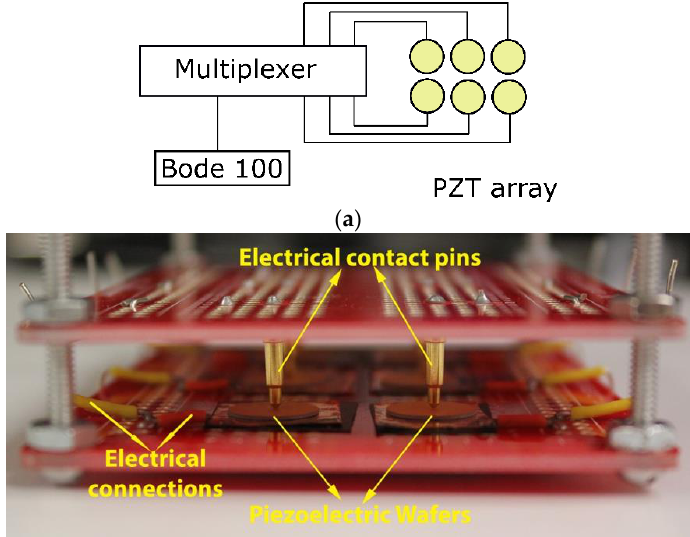
Figure 4. ( a ) Schematic of the experimental setup and ( b ) a picture of the piezoelectric wafer array in the experimental setup. The copper grounding pads and the pogo pins can be seen making contact with the piezoelectric circular wafers.